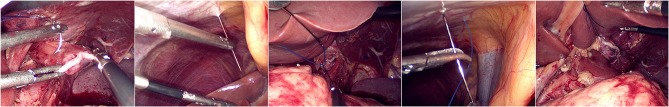
Esophageal right side suspension and fixation.